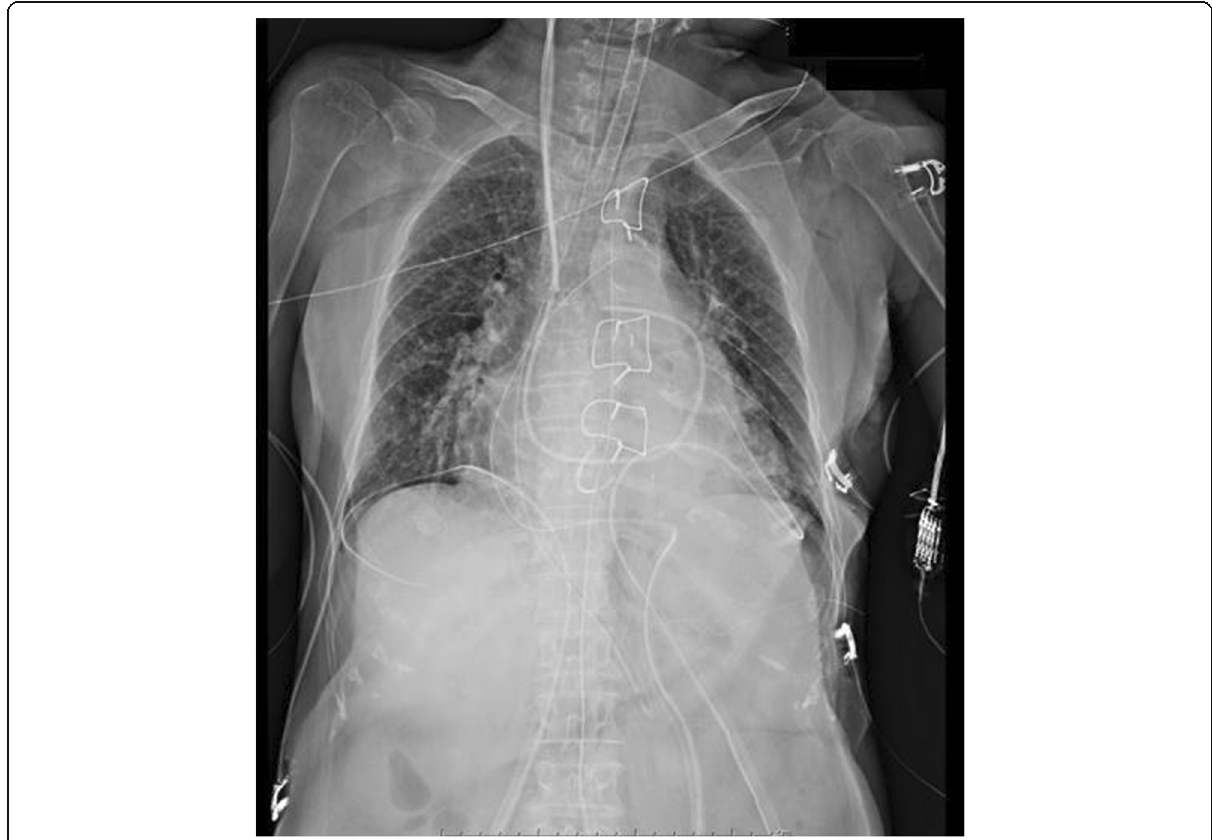
Fig. 1 Chest radiography just after the cardiac surgery. The course and the tip position of the NG tube were unusually shifted to the